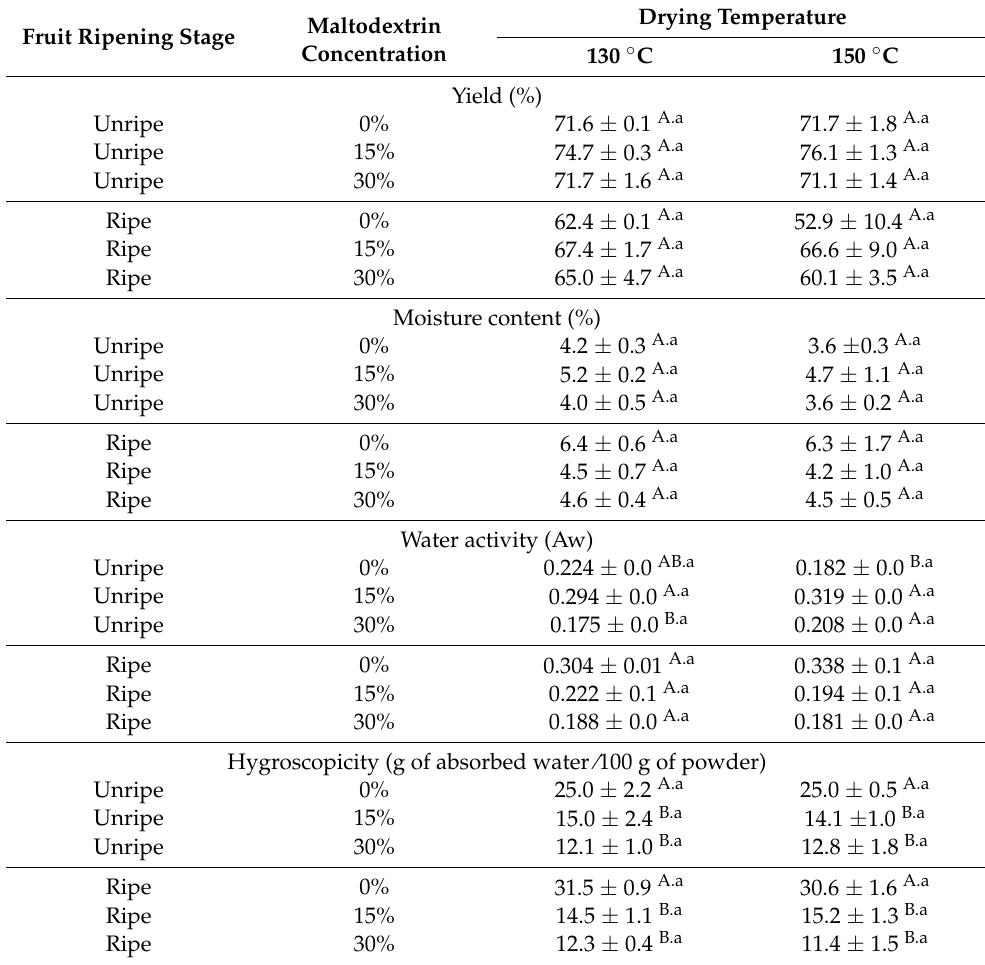
Table 2. Yield, moisture content, water activity, hygroscopicity, dispersibility, color parameters (L*, a*, b*) and average particle diameter of each powder produced by spray drying of papaya seed extracts with maltodextrin as a